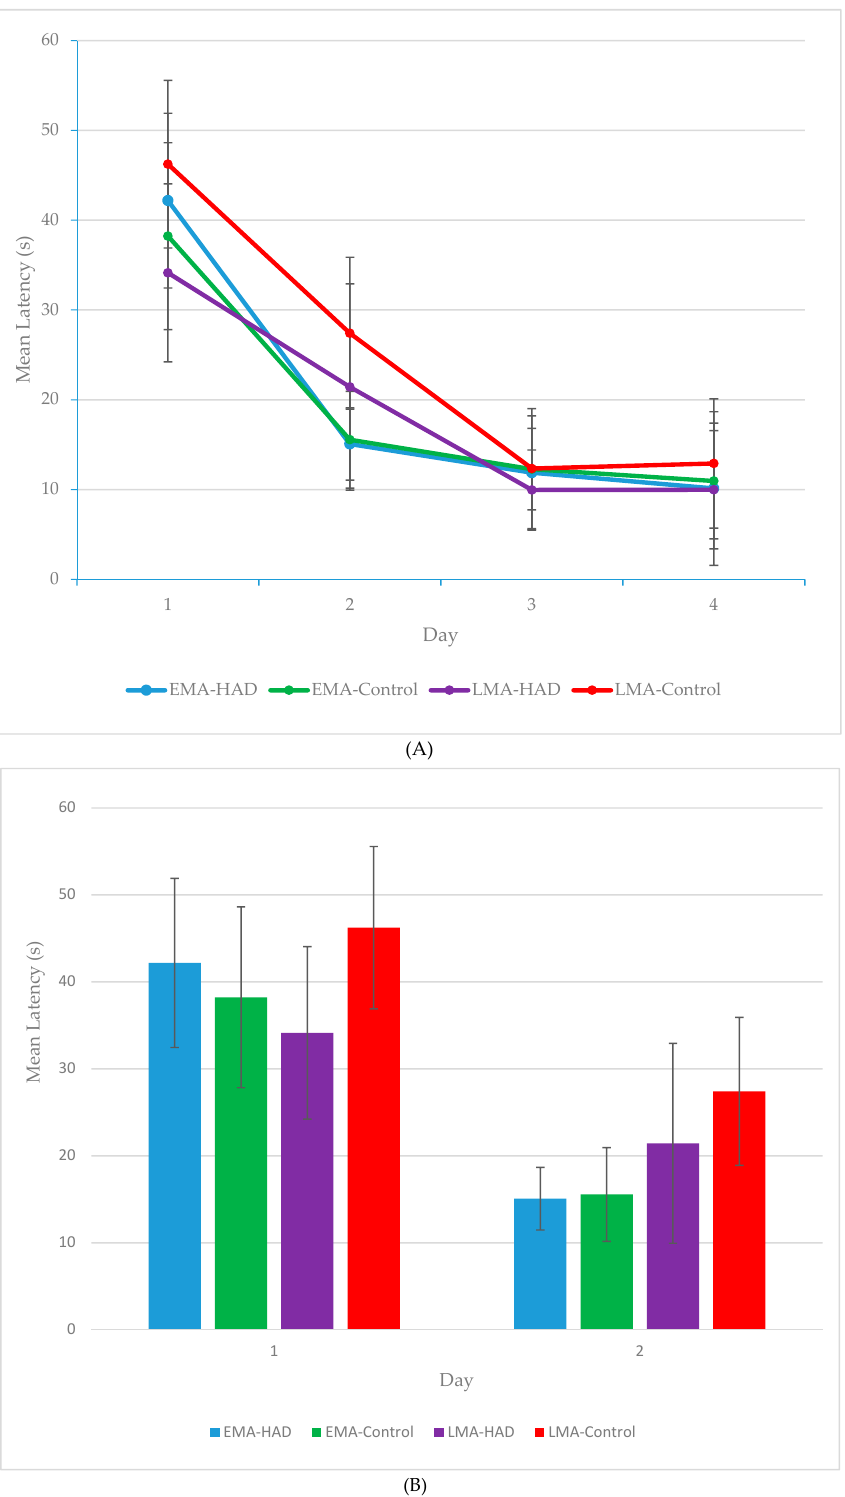
Figure 1. ( A ) Mean latency in seconds (s) for each condition on each training day (collapsed across the four daily trials). LMA-HAD (Late middle-age-high antioxidant diet) rats performed as well on days 1 & 2 as EMA rats, whereas LMA-Controls lagged behind until day 3. Error bars represent Standard Deviation (SD). ( B ) Mean latency in seconds (s) for each condition on training days 1 & 2 (collapsed across the four daily trials). LMA-HAD rats performed as well on days 1 & 2 as early middle age rats, whereas LMA-Controls lagged behind until Day 3. Error bars represent SD. Path Length A 4 × 4 mixed design ANOVA examining mean path length in centimeters (converted from inches) by day and condition revealed a pattern of results very similar to latency, revealing significant main effects of day, F (3, 114) = 120.75, p = 0.000, η p 2 =0 .76, and condition, F (3, 38) = 3.25, p = 0.032, η p 2 = 0.20, and a significant interaction, F (9, 114) = 2.23, p = 0.034, η p 2 = 0.15. Examination of effect sizes again indicates that while the largest effect on path length is attributable to differences across days, both condition and the interaction between condition and day represent medium-sized effects. Paired t -tests with a Bonferroni correction were used to analyze the nature of the main effect of day and revealed that mean latency decreased significantly between each of the days except for between days 3 and 4, p < 0.001 for all significant comparisons, day 1 ( M = 1138.96, SD = 314.40); day 2 ( M = 619.43, SD = 301.71); day 3 ( M = 353.36, SD = 171.86); day 4 ( M = 305.92, SD = 189.79). The nature of the main effect of condition was examined by Tukey HSD test, which determined that LMA-Controls performed significantly worse ( M = 716.89, SD = 42.19) than LMA rats on the HAD ( M = 555, SD = 42.19, p = 0.047), confirming that older rats on the HAD outperformed their standard diet counterparts.